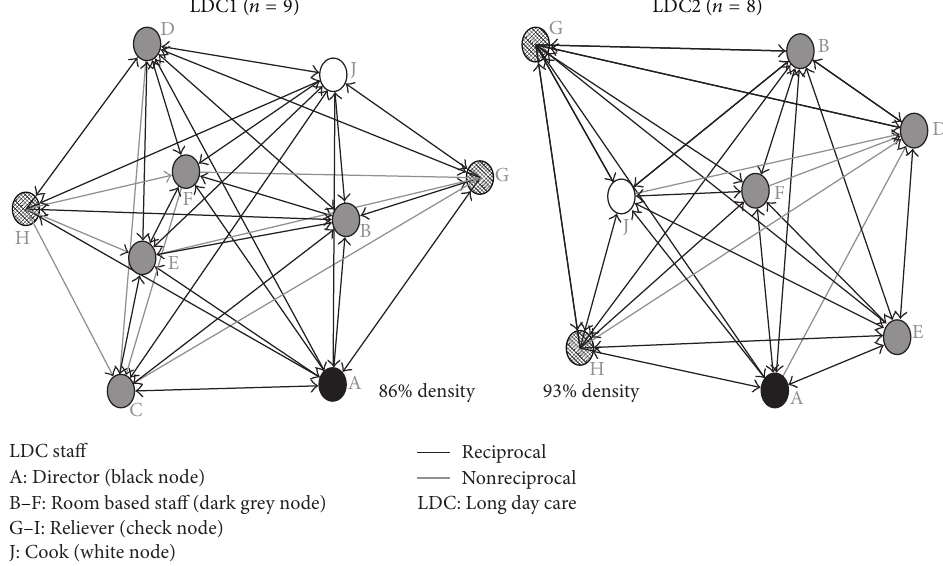
Figure 1: LDC1 and LDC2 information frequency networks.